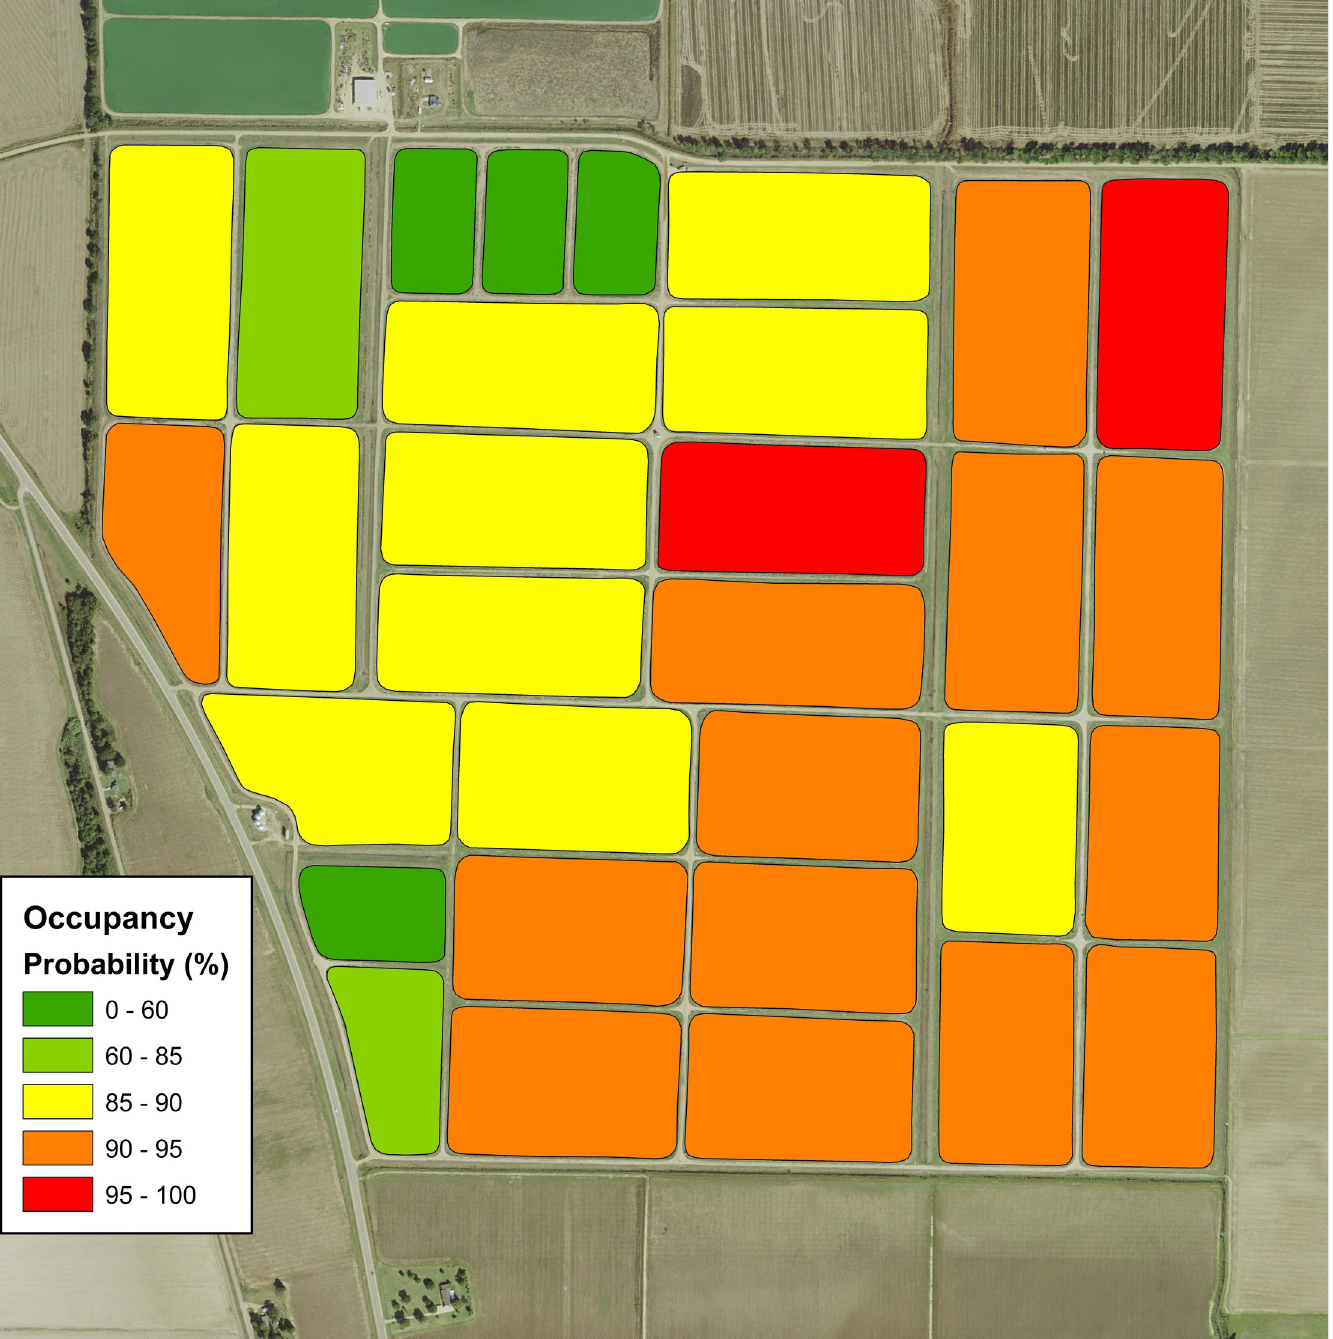
PLOS ONE | https://doi.org/10.1371/journal.pone.0229402 February 26,